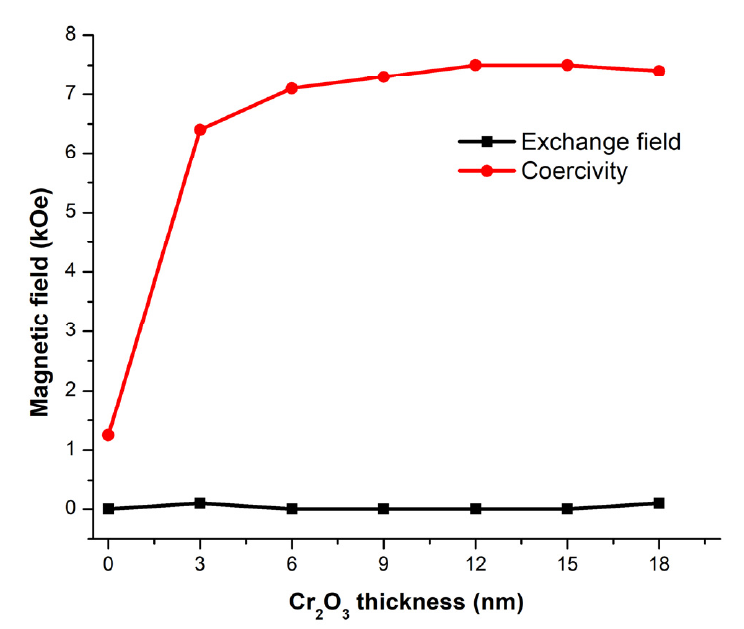
Figure 12. The plot of the exchange field and coercivity field of Terfenol–D coupling with Cr 2 O 3 at the Cr 2 O 3 thickness of 0–18 nm.